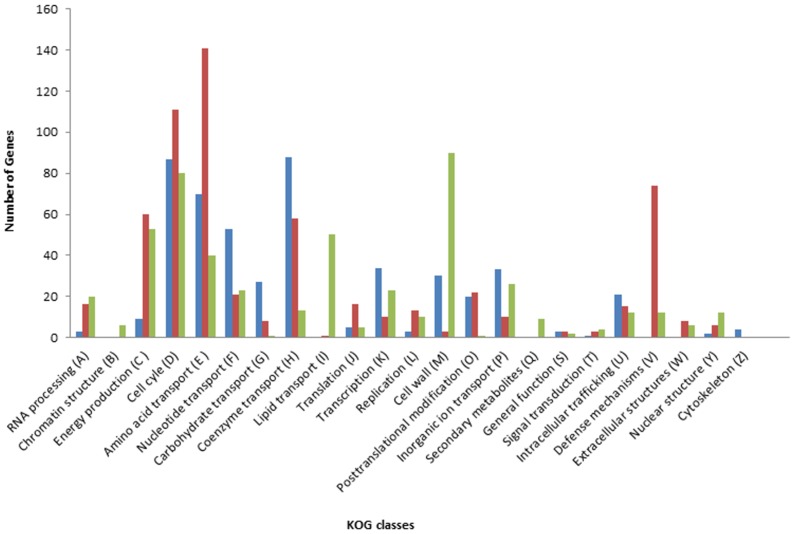
Functional classification of significantly enriched genes in mock- and rust-inoculated (0, 12 and 84 hai) leaves of common bean.The GO enriched genes are functionally classified based on EuKaryotic Orthologous Groups (KOGs). KOG categories are presented on X-axis and number of genes in the corresponding classes are shown on Y-axis.